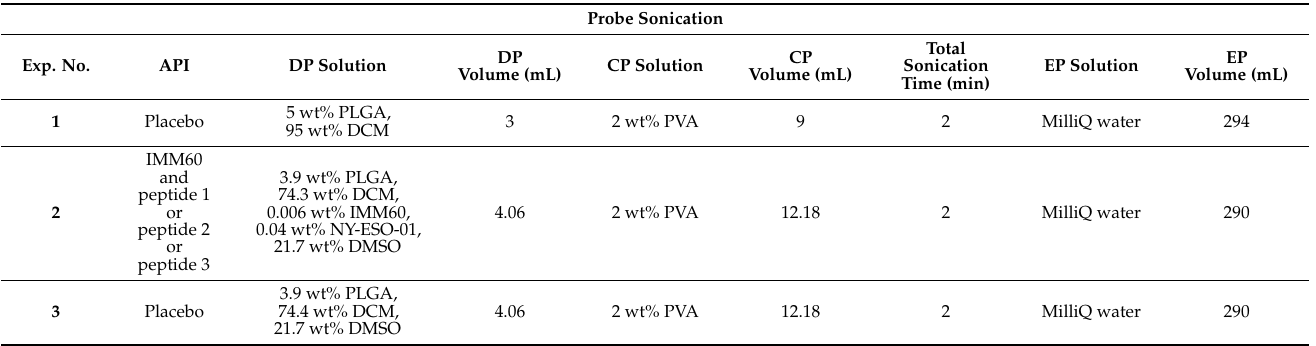
Table 1. Process parameters used for the formulation assessment and the production of immunomod- ulating nanovaccines with the probe sonication method. Probe